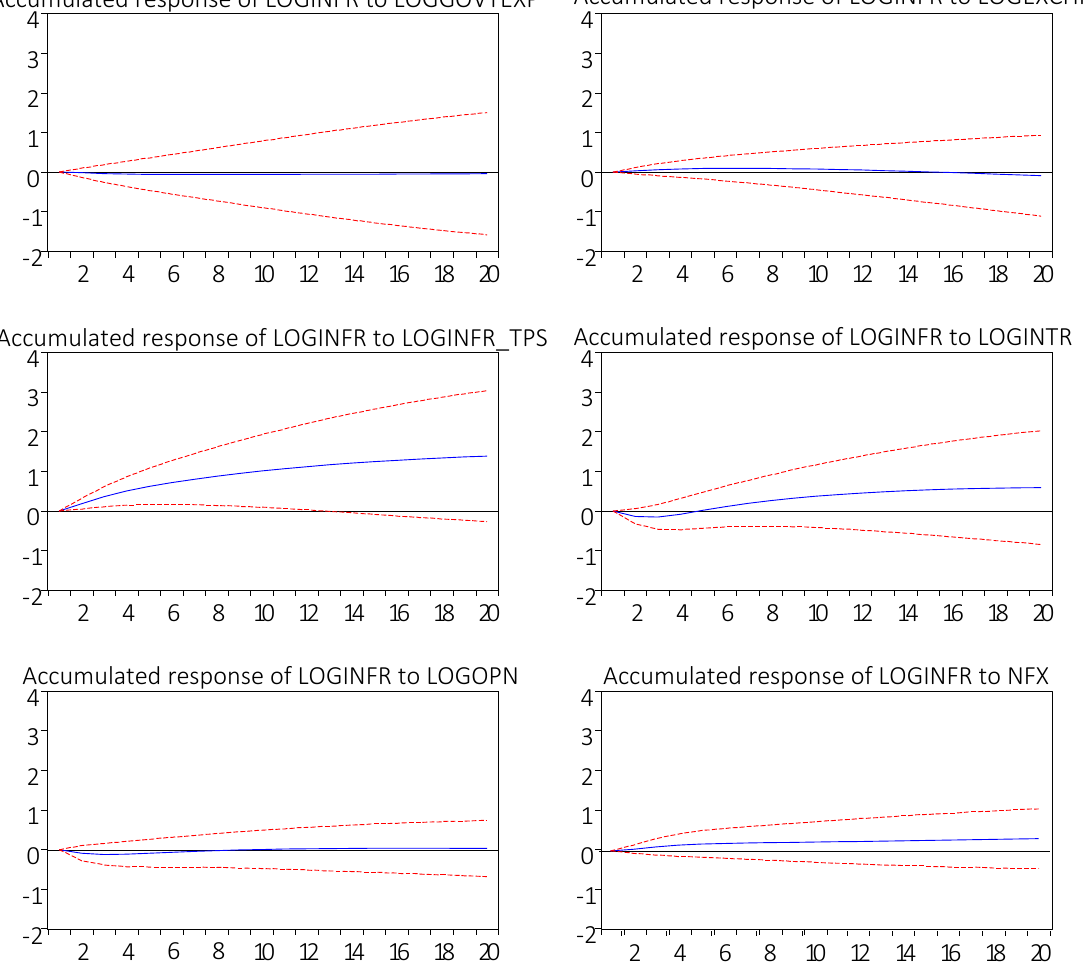
Figure 2. Individual responses of inflation to one standard deviation shocks from